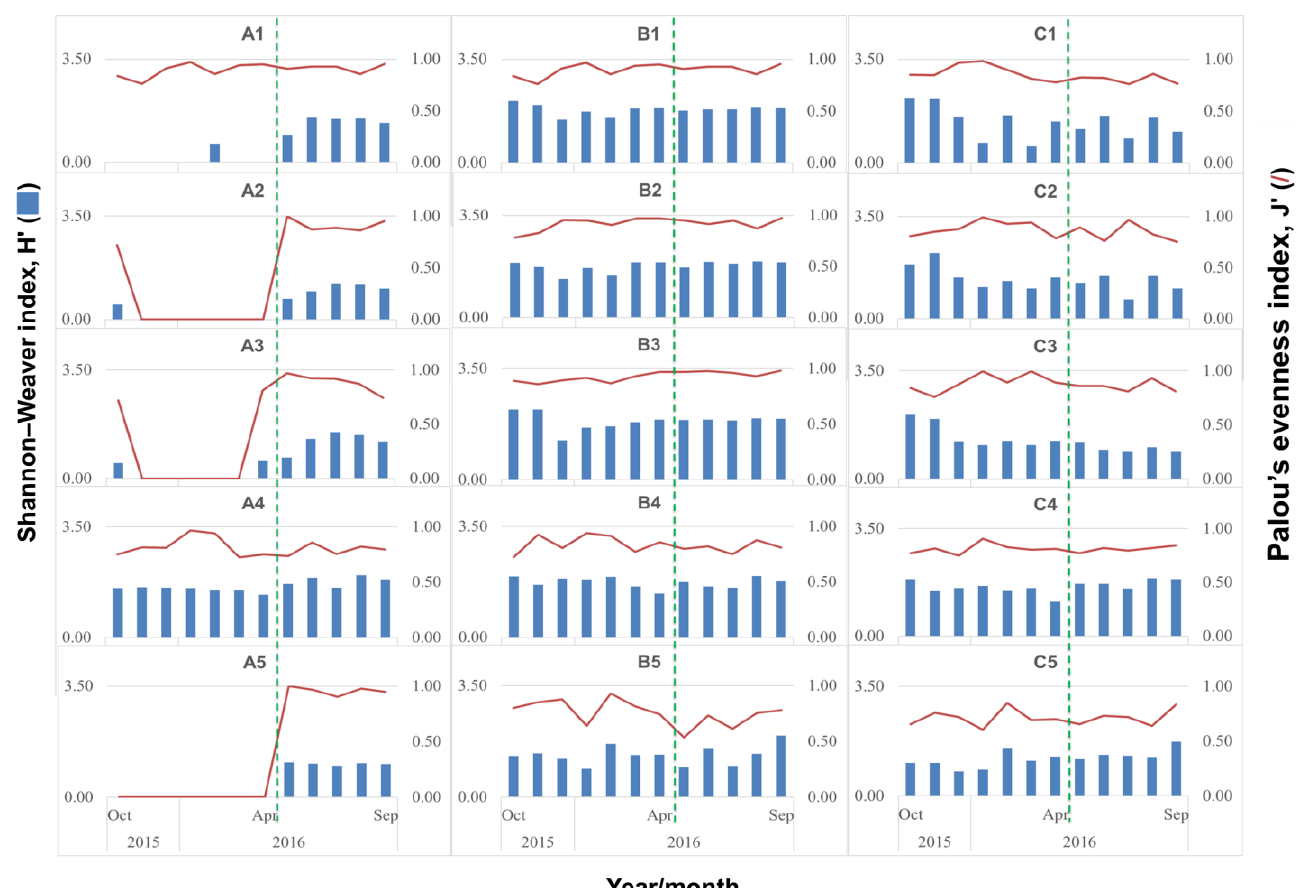
(cid:48) ) and Palou’s evenness index (J (cid:48) ) over the survey period. Figure 3. Shannon–Weaver index (H’) and Palou’s evenness index (J’) over the survey period. Figure 3. Shannon–Weaver index (H